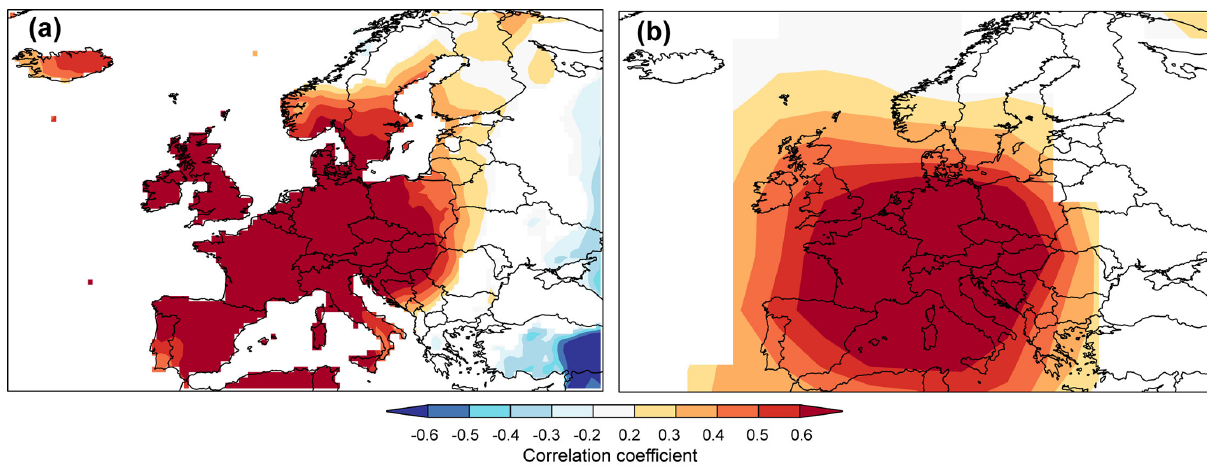
Figure 17. Spatial correlations between (a) JJA reconstructed temperatures (Dobrovolný et al., 2010) and temperature field reconstruction (Luterbacher et al., 2004) for the 1600–1750 period as well as between (b) JJA measured temperatures (Dobrovolný et al., 2010) and HadCRUT5.0 temperature field (Morice et al., 2020) for the 1851–2000